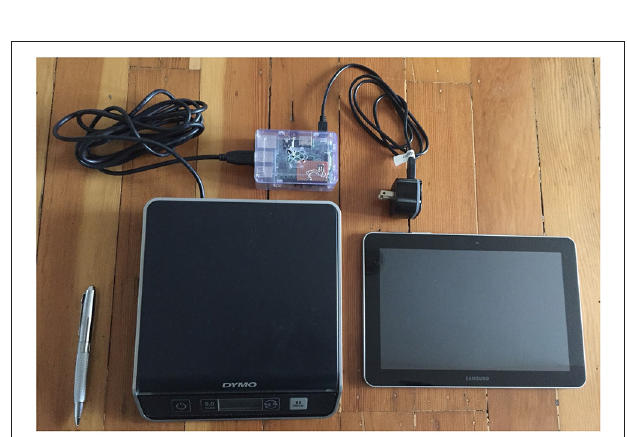
FIGURE 2 | Parts of the E-COmate prototype: a DYMO scale [left below], SAMSUNG tablet [right below], and a Raspberry Pi